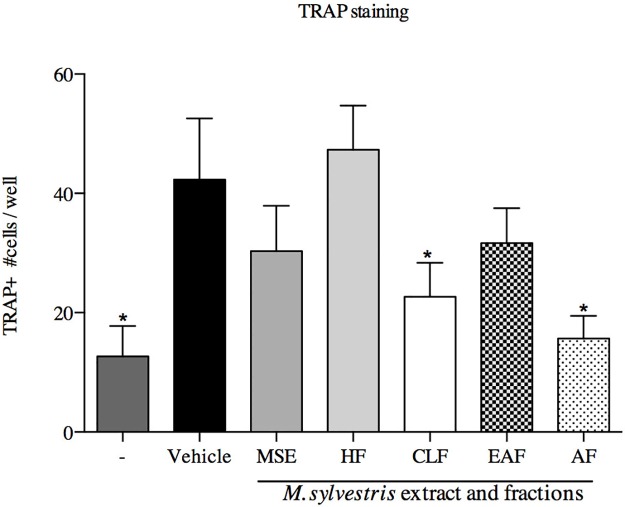
Activity of M. sylvestris and fractions in RANKL-mediated osteoclast differentiation.RAW 264.7 cells were stimulated with sRANKL (50 ng/ml) for 6 days. Cells were fixed and stained for TRAP. TRAP+ multinuclear cells were counted. Data represent mean ± SD of three cultures. * p<0.05; significantly lower than sRANKL-stimulated group.